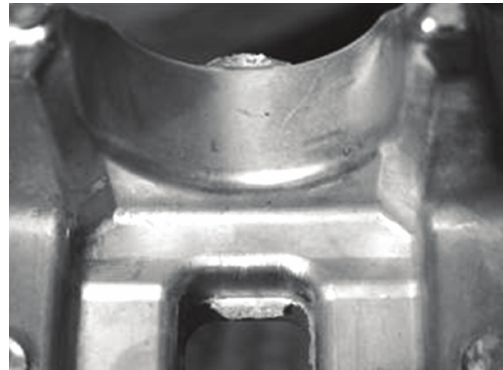
Figure 6: An example of a visually inspected and passed brake caliper casting produced during trials with the CSIR-RCS-HPDC cell without any external